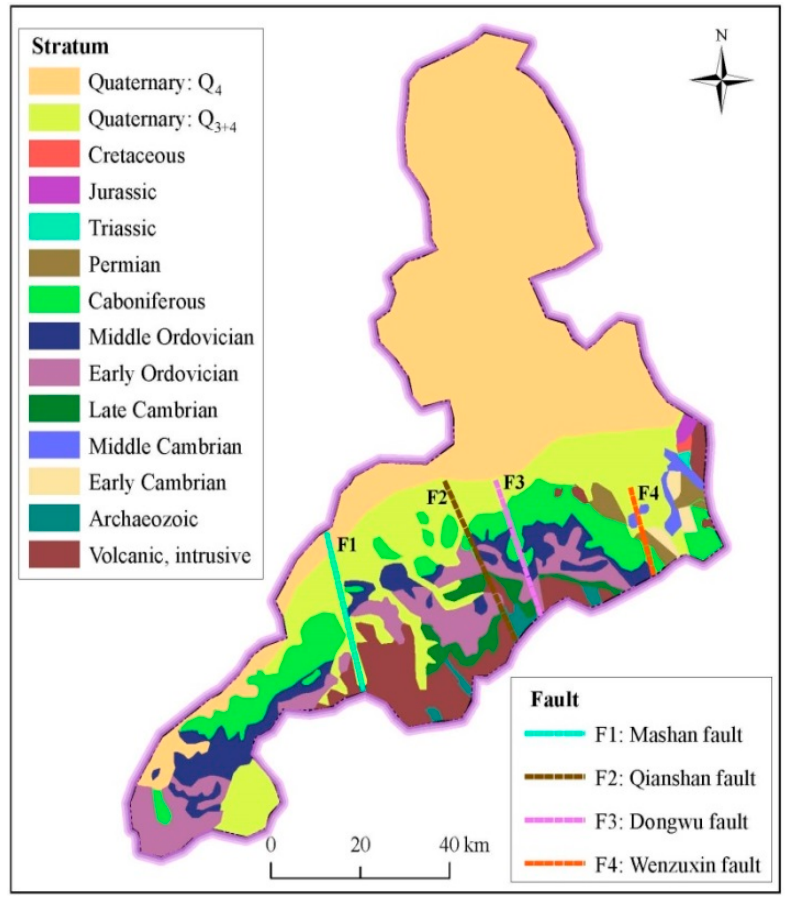
Figure 7. Spatial distribution of strata in Jinan.